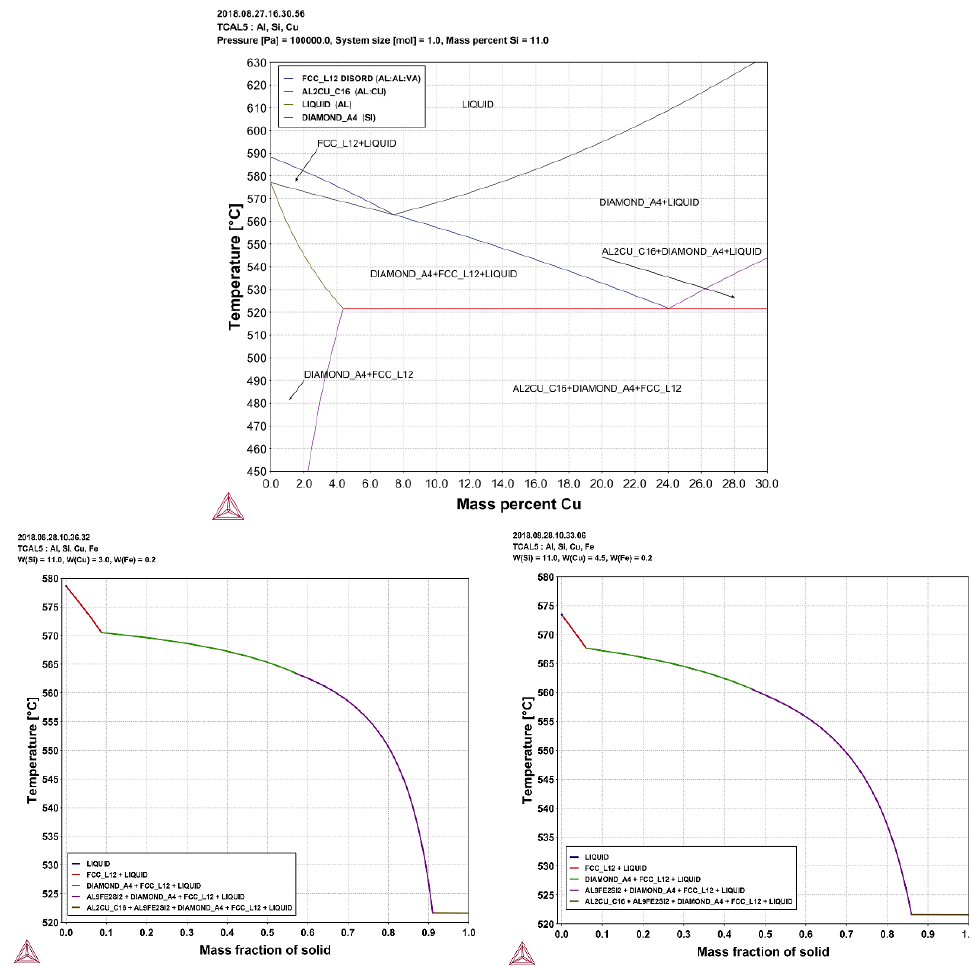
Figure 10. Partial pseudo-binary Al-11wt. %Si- x Cu phase diagram, and graphs of temperature versus the solid fraction (solidification paths), computed by the Thermo-Calc software for alloys containing 0.2 wt. % Fe.